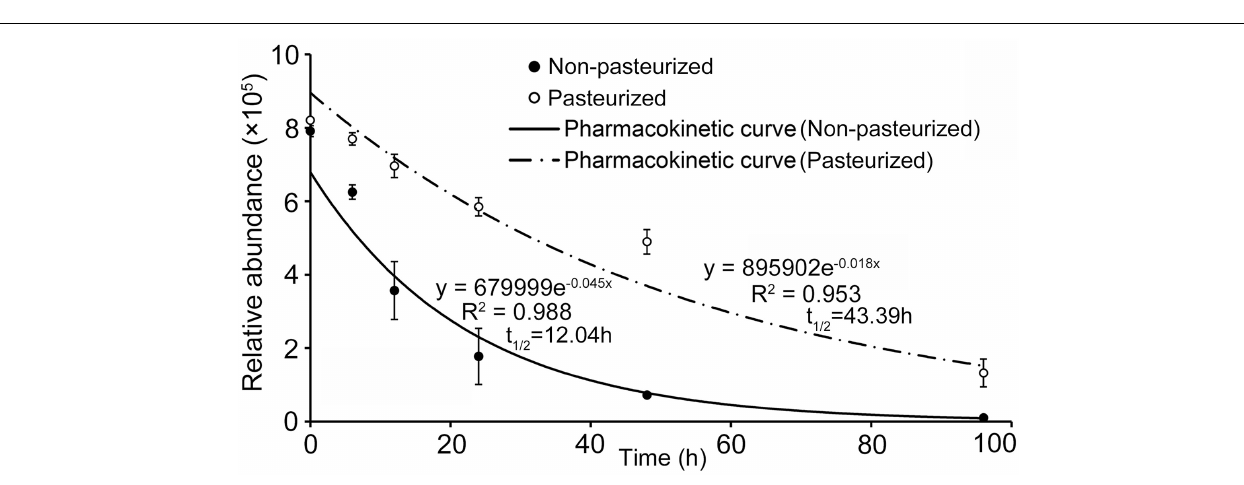
FIGURE 8 | Degradation and soil half-life of catalpol in non-pasteurized and pasteurized